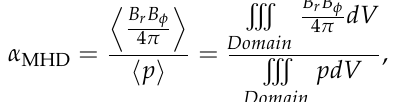
(cid:1) (cid:11) (cid:10) ( (cid:0) B r / B 0 ) B φ / B 0 /4 π / (cid:104) p / p 0 (cid:105) . √ r 2 + z 2 / R 0 < 0.3. Colors